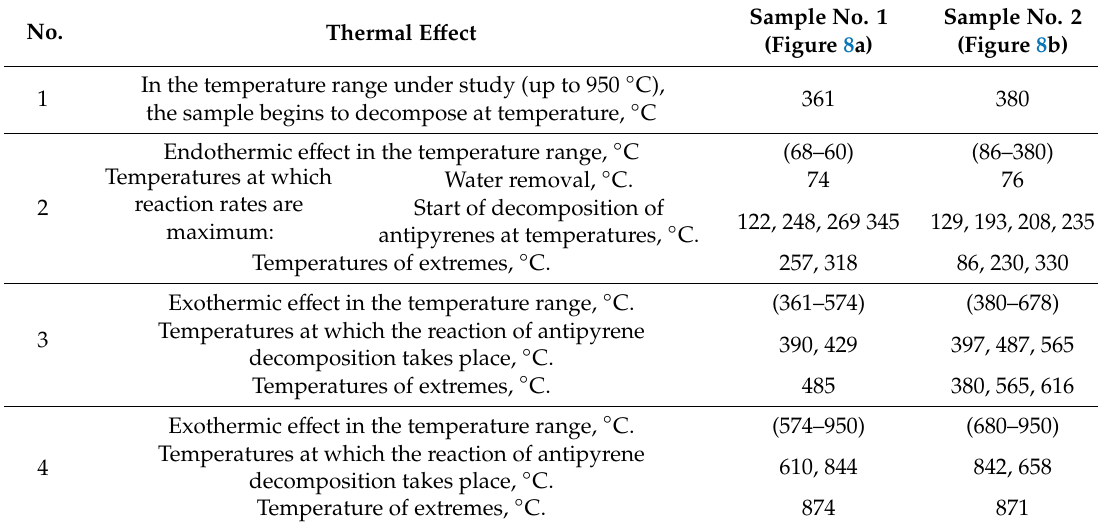
Table 4. Conclusions on the thermograms of the tested fireproof paint